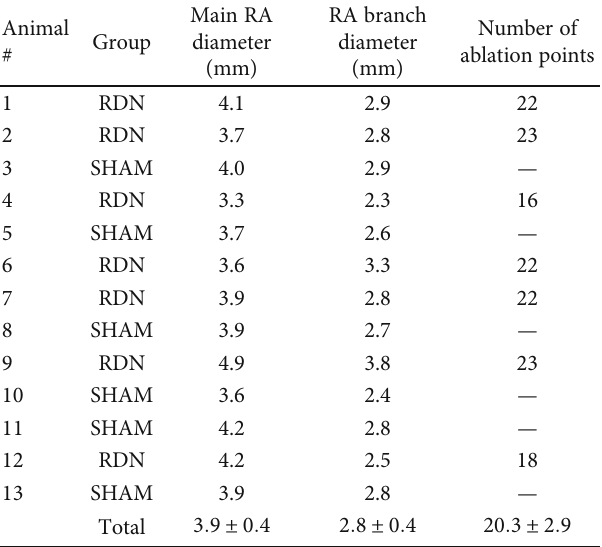
Table 1: Angiographic characteristics of renal arteries and number of RF ablation points in each animal.